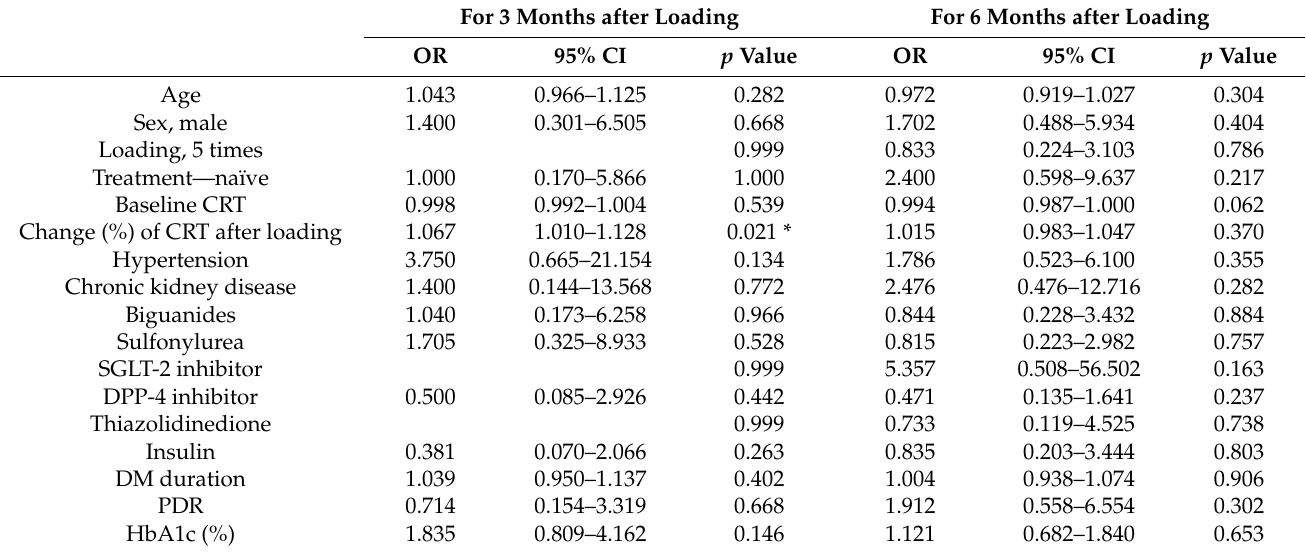
Table 3. Factors associated with stability of eyes for 3 months vs. 6 months after loading. For 3 Months after